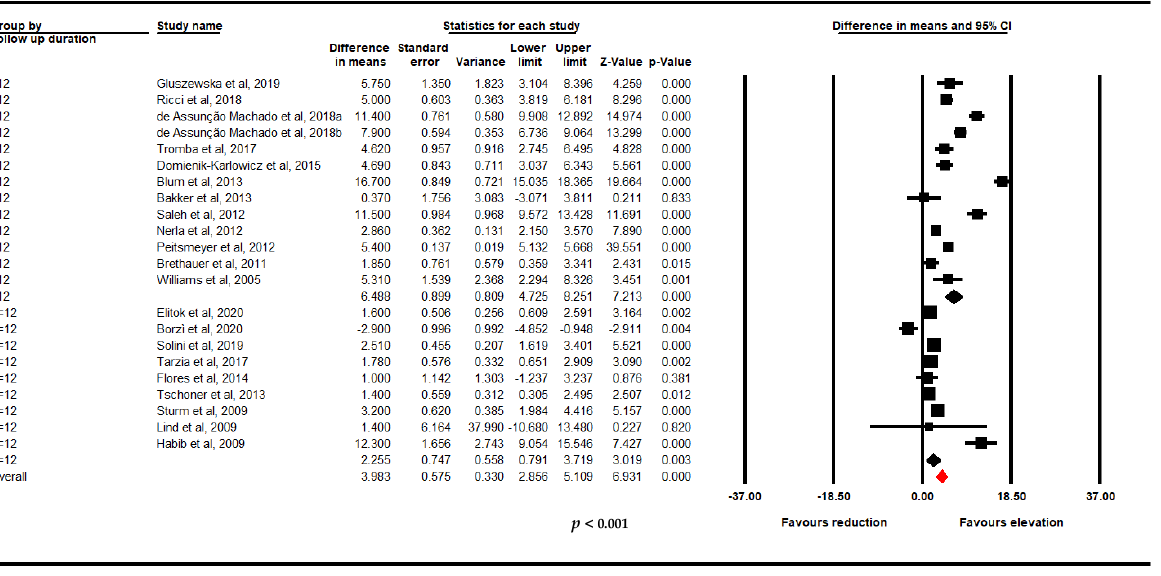
Figure 6. Subgroup analysis based on the follow up duration.